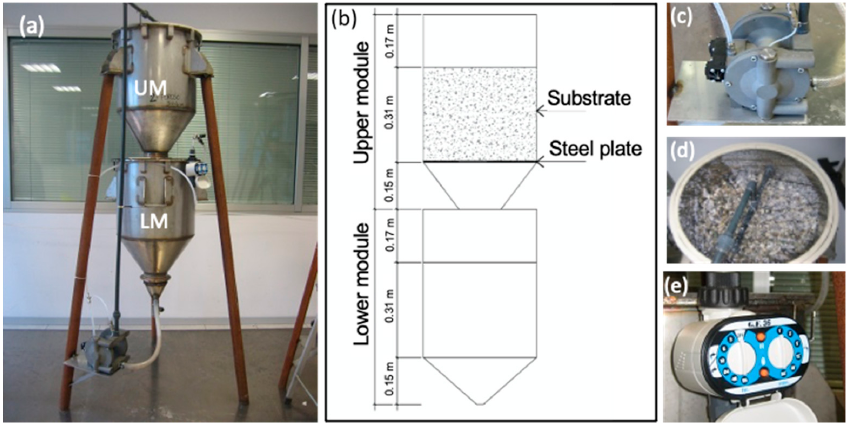
Figure 1. Description of filter structure: ( a ) upper (UM) and lower (LM) filter modules; ( b ) mod- ules’ internal structure with dimensions expressed in mm; ( c ) vacuum pump; ( d ) plastic cap; ( e ) timer.